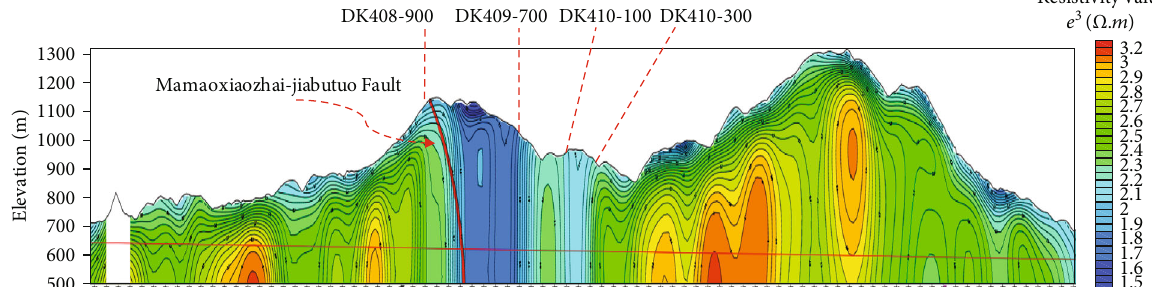
Figure 2: Magnetotelluric inversion results.